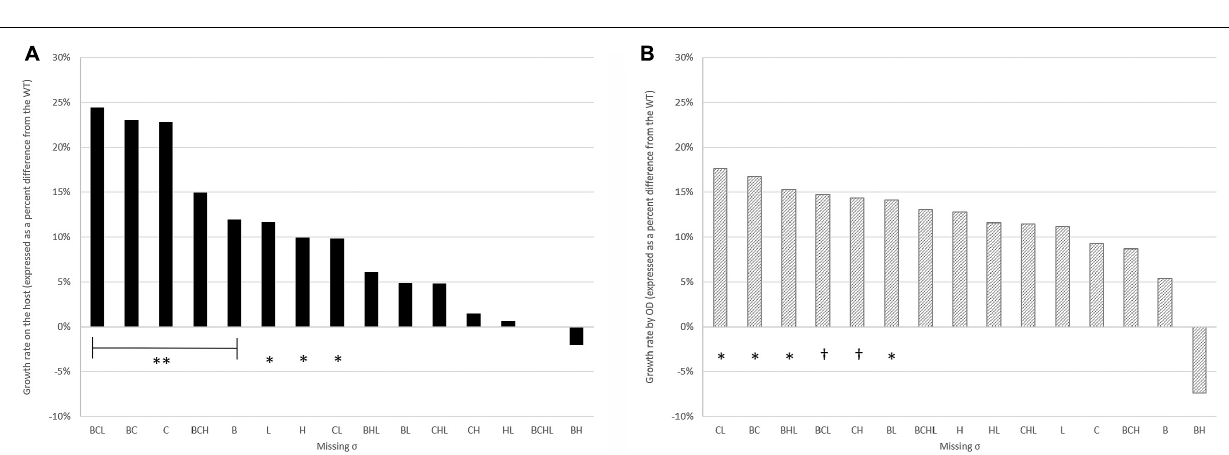
FIGURE 3 | Growth rates on the Caco-2 host (A) and by OD measurement from BHI (B) expressed as percent differences from the WT. Median percentage values were used in the plot. ∗∗ indicates significant difference from WT at p ≤ 0.01, ∗ indicates significant difference from WT at 0.01 < p ≤ 0.05, and † indicates p ≤ 0.07. All experiments were performed in biological